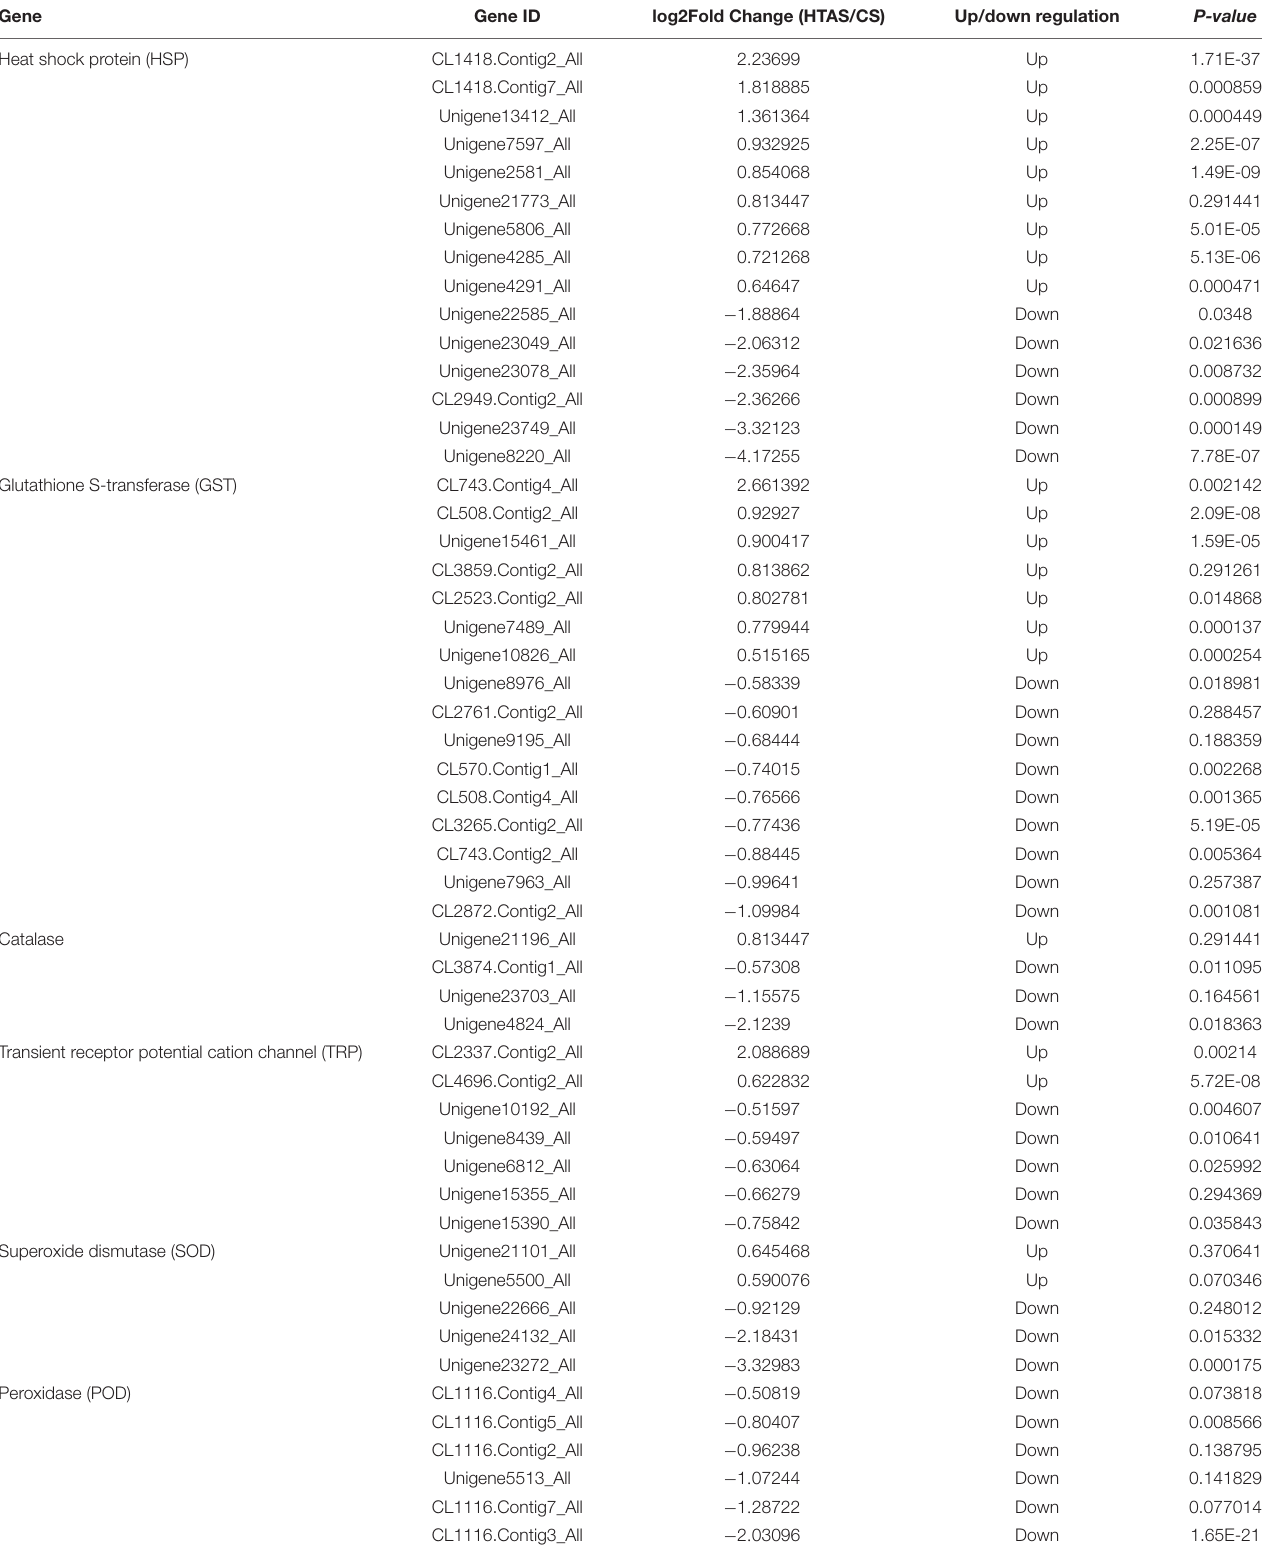
TABLE 2 | Differentially expressed genes within protective enzymes in two strains of Neoseiulus barkeri. Gene Gene ID log2Fold Change